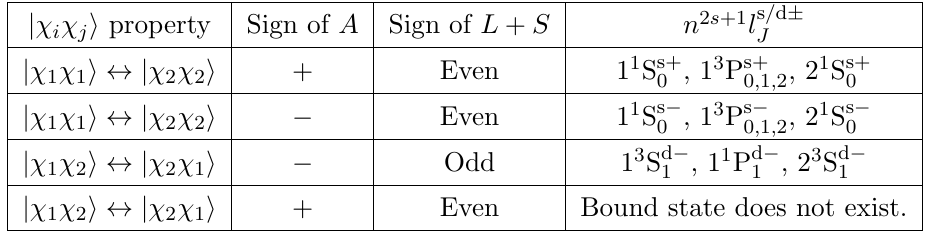
Table 1 . Quantum characters of di(cid:11)erent